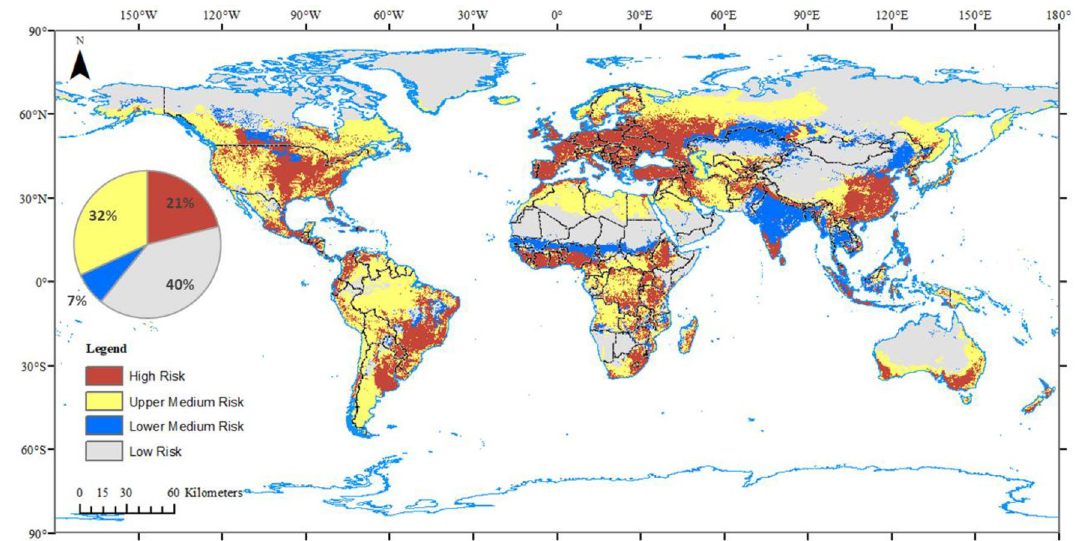
Figure 2. Global risk regions for Globodera rostochiensis and G. pallida . Grey areas have neither suitable environment nor cultivated land. Blue areas represent cultivated land with unsuitable environmental conditions. Yellow regions represent suitable environment with small areas of cultivated fields. Red areas are cultivated lands with suitable environments for at least one of G. rostochiensis and G. pallida . The pie chart shows the proportion of each risk level on the entire global land surface. Global bioclimate data were acquired from the WorldClim open database (https:// world clim. org). The locations of species occurrence were collected from open databases: GBIF (http:// www. gbif. org), CABI (http:// www. cabi. org/ isc) and EPPO (http:// www. eppo. int). The species distribution model was conducted with Maxent (Version 3.4.1, http:// biodi versi tyinf ormat ics. amnh. org/ open_ source/ maxent/), and modified with ArcMap (version 10.4.1, https:// www. arcgis. com/).